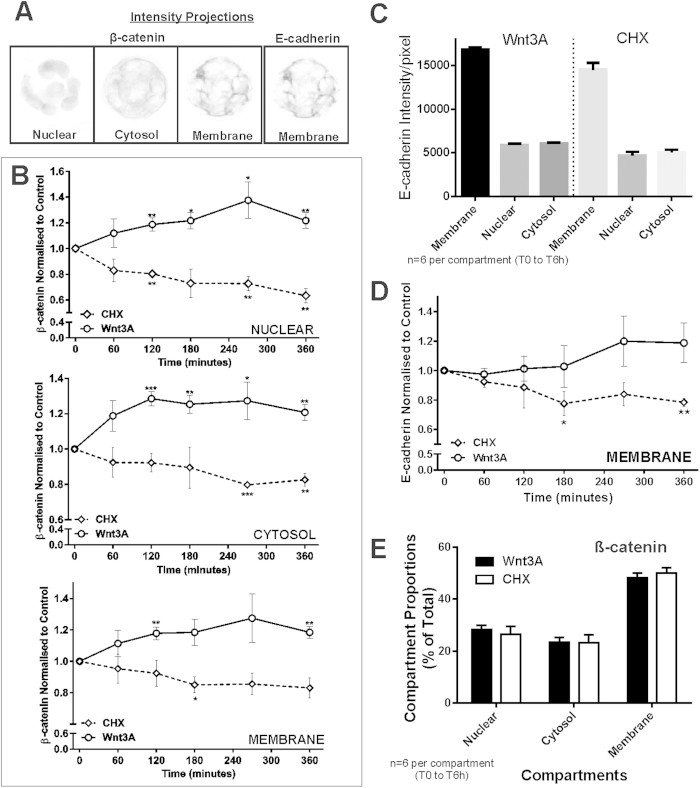
Quantitative analyses of compartment β-cat and E-cad dynamics in colonospheres.(A) Intensity projections of 3D β-cat (nuclear, cytosol or membrane compartments) and E-cad (membrane only) of day 2 colonospheres. (B) Relative subcellular compartment β-cat intensity of colonospheres under Wnt3A stimulation or CHX inhibition (1, 2, 3, 4.5 or 6 hours). Nuclear β-cat increased significantly after 2 hours of Wnt3A stimulation and decreased significantly after 2 hours of CHX inhibition. Relative cytosolic β-cat increased significantly after 2 hours of Wnt3A stimulation while under CHX inhibition, a slow decrease was observed which became significant after 4.5 hours of inhibition. Relative membrane β-cat increased slightly under Wnt3A stimulation (significant after 2 hours of stimulation) with a very slow decrease observed under CHX inhibition. (C) Average compartment E-cad intensity (all T0 to 6 hrs) for either Wnt3A or CHX treatment. The nuclear E-cad intensity detected was treated as background control (the antibodies used recognize only E-cad extracellular domain). In both treatments, the average E-cad intensity/pixel for both nuclear and cytosol compartments are similar, rendering cytosolic E-cad intensity detected as background. E-cad analyses therefore only consisted of the membrane compartment (minus the corresponding nuclear intensity as background correction). (D) The relative E-cad levels (background corrected) under Wnt3A stimulation or CHX inhibition. E-cad levels increased variably by 20% (p > 0.05 for each time-point) after 6 hours of Wnt3A stimulation. CHX decreased the E-cad levels by 20% after 3 hours (p < 0.05). (E) Compartment proportions (% nuclear, cytosol or membrane) of β-cat intensities were tabulated for all colonospheres under the two treatments (T0-T6 h). No change in compartment proportions was observed under either Wnt3A or CHX perturbations. Wnt3A n = 5, CHX n = 3, statistical test: single-factor anova analysis relative to T0: *p < 0.05, **p < 0.01, ***p < 0.001. Total colonospheres count:296. Error bars: ± SEM